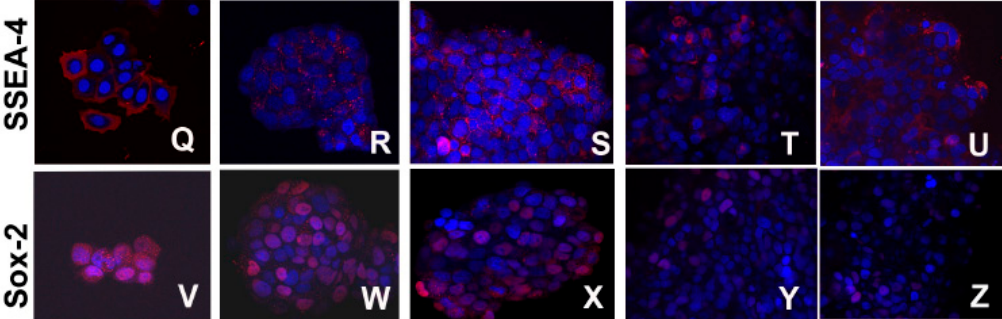
Figure 3. Morpho ‐ functional characterization of cells during early spheroid formation. ( A – C ) SEM ( A ) and immunofluorescence ( B , C ) analysis of MCF7 cells during the early phases of aggregation. Cell communications are established via TNTs, evidenced ultrastructurally ( A ) (arrowheads) and by immunofluorescence stainings ( B , C ). The nanocanals are confirmed by intensive labelling showing the expression of testis expressed gene 14 (TEX14) ( B ) (arrowhead) and of actin ( C ) confined along the internal face of TNT plasma membrane (arrowheads). Nuclei are stained with 4 ′ ,6 ′‐ diamino ‐ 2 ‐ phenylindole (DAPI) and marked in brilliant blue. Scale bar: ( A ) 7 μ m. ( D – K ) Identification of amyloid fibrils localized by bright green fluorescence of thioflavine S (ThS) and by expression of melanocyte protein (Pmel17) (red) in MCF7 cells during early aggregation phase (24h) ( D , E ), after 3 days ( F , H ), and only superficially in mature spheroids at 5–7 days ( I – K ). Nuclei are stained with DAPI. Separate staining for ThS ( D , G , I ) and Pmel17 ( E , F , H , J , K ), are proposed to better evaluate each signal identifying the presence of amyloid materials. ( L – P ) The overall degree of cytoplasmic ROS is detected using the fluorescence dye 2 ′ ,7 ′‐ dichlorodihydrofluorescein diacetate (H2DCFDA). Comparison among the upper series of photographs showing only the staining for ROS with the related lower series, showing superimposed bright field images and ROS localization, is proposed to provide a better evaluation of the signal strength and its localization in the various developmental stages of spheroid. The signal (green) persists during all developmental stages of spheroid with not-significative decrease in the last phase of development. Early (24 h) aggregation phase ( L , M ), 3 days spheroid ( N ), 5–7 days ( O ), and 11–16 days spheroid culture ( P ). ( Q – Z ) Comparison of the expression of stemness markers stage-specific embryonic antigen-4 (SSEA-4) ( Q – U ) and SRY (sex determining region Y)-box 2 (Sox2) ( V – Z ) from 24 h aggregates ( Q , V ), and 3 ( R , W ), 5–7 ( S , X ), and 11–16 ( T , Y , U , Z ) days